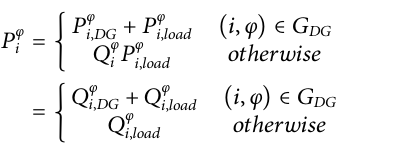
FIGURE 1 | Active and reactive power feasible region of